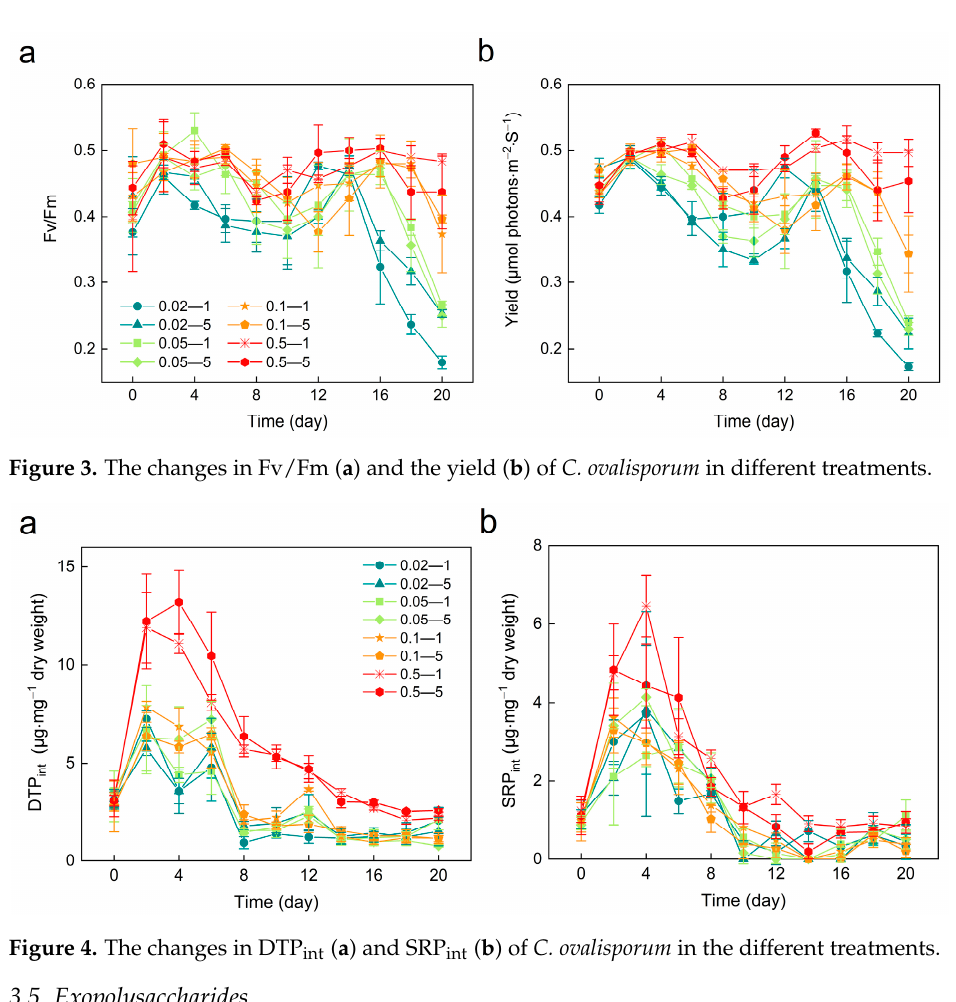
Figure 4. The changes in DTP int and SRP int of C. ovalisporum in the different treatments.